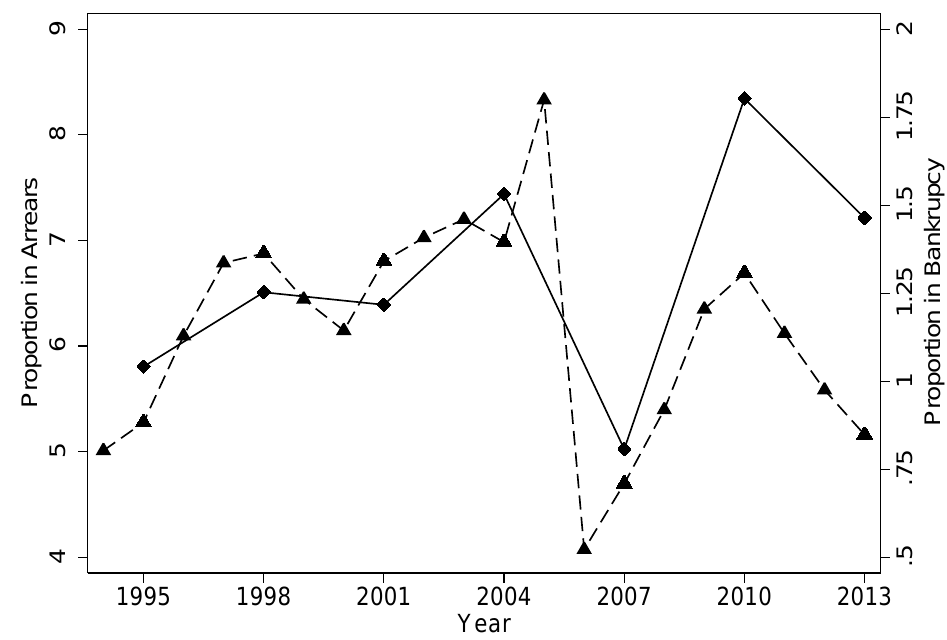
Figure 1. Comparing SCF Arrears to Bankruptcy Filings. Note: US Bankruptcy Filing Rate drawn with dashes (right-axis) and Arrears reported in the SCF drawn with solid line (left-axis). Authors own calculations using the SCF and using the non-business bankruptcy filings reported by the American Bankruptcy Institute divided by the number of US households reported by the US Census